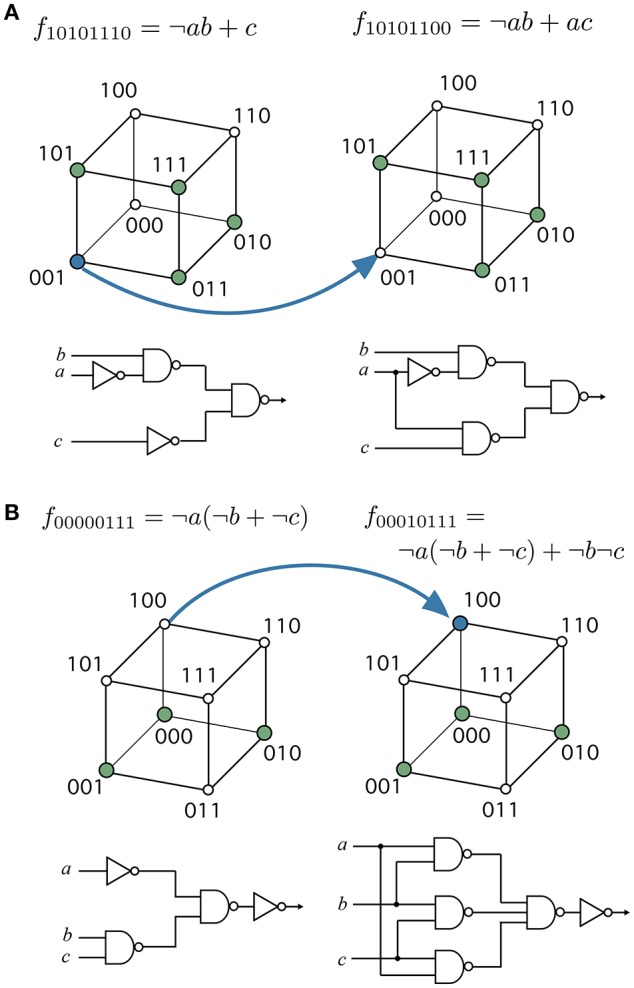
Evolving specific functions might involve a breakdown of modularity. (A) the multiplexer function has functional modularity Q(10101100) < Q(10101110), and (B) the majority function has Q(00010111) < Q(000000111). These target functions can be evolved from more modular ancestors, that is, functions with specific groups of inputs affecting different groups of outputs. Blue arrows represent edges in the phenotype network or the specific changes transforming the source function into the target function. Each function is represented with their minimal normal disjunctive form (top), hypercube (middle), and minimal FFBN (bottom).